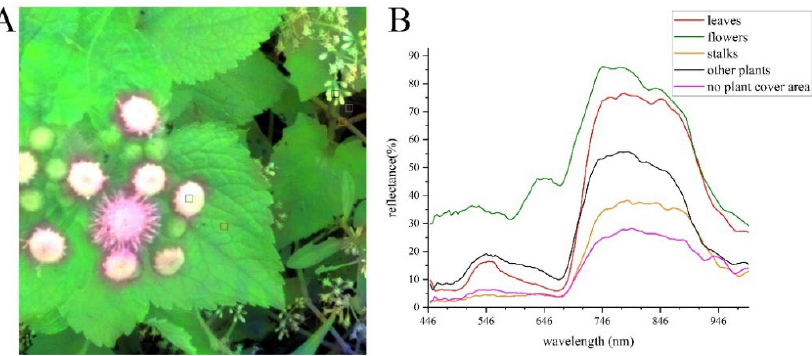
Figure 2. Extraction of raw spectral data. ( A ) Pixels of hyperspectral images used for raw spectra extraction, ( B ) raw spectral data.